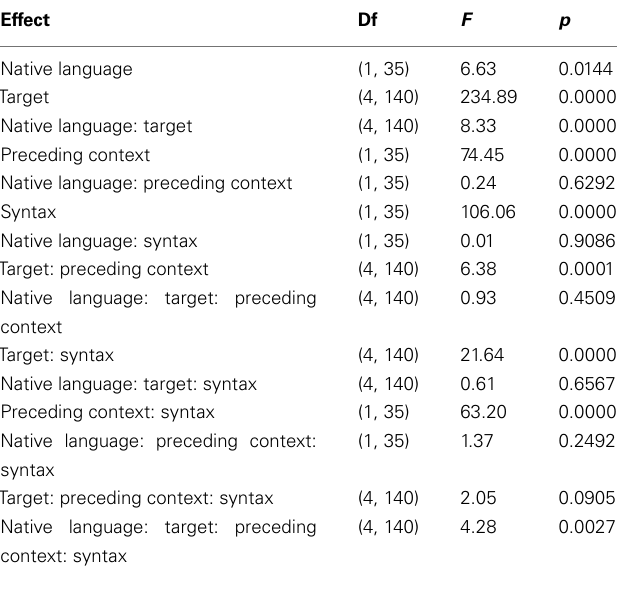
Table 5 |Analysis of variance table for Experiment